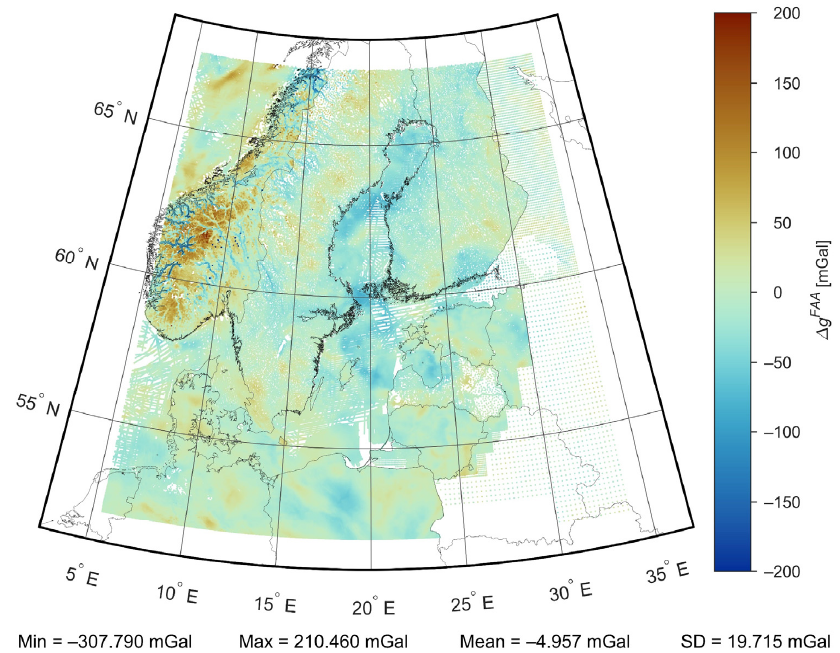
Figure 2. Surface free-air anomalies (final release of BSCD2000 dataset version 3).